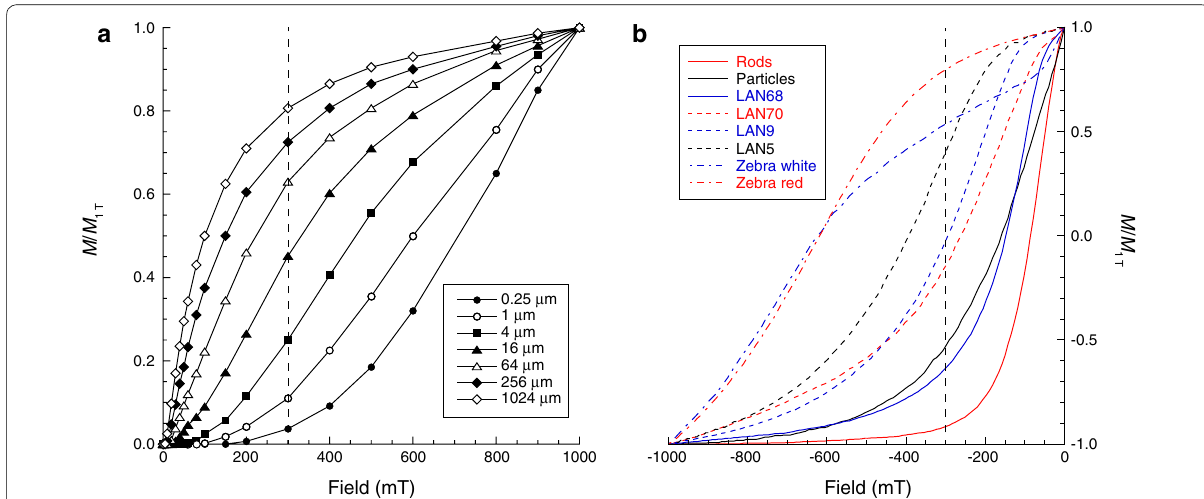
Fig. 5 IRM acquisition and backfield demagnetization curves for hematite samples. a IRM acquisition curves for known hematite size fractions, where finer sizes are more resistant to acquisition (and vice versa). Redrawn from Thompson (1986). b Backfield demagnetization curves for SD hematite samples measured at the Australian National University (where DC demagnetization curves are equivalent to IRM acquisition curves with twice the amplitude and opposite slope for non‑interacting SD particles). Two samples (particles, zebra white) have steep initial slopes due to magnetically soft hematite near the superparamagnetic/SD threshold size and are then dominated by higher coercivities. Zebra samples are pigmentary hematite from Abrajevitch et al. (2018). LAN samples are natural nanocrystalline hematite samples from deeply weathered regolith from Lancefield South gold mine, Western Australia. ‘Particles’ are equidimensional hematite nanoparticles (45–85 nm particle sizes) and ‘rods’ are nanorods (250–350 nm (length) 50–100 nm (width)) that were synthesized hydrothermally (Islam et al. 2012). Dashed vertical lines represent the × 300‑mT cut‑off